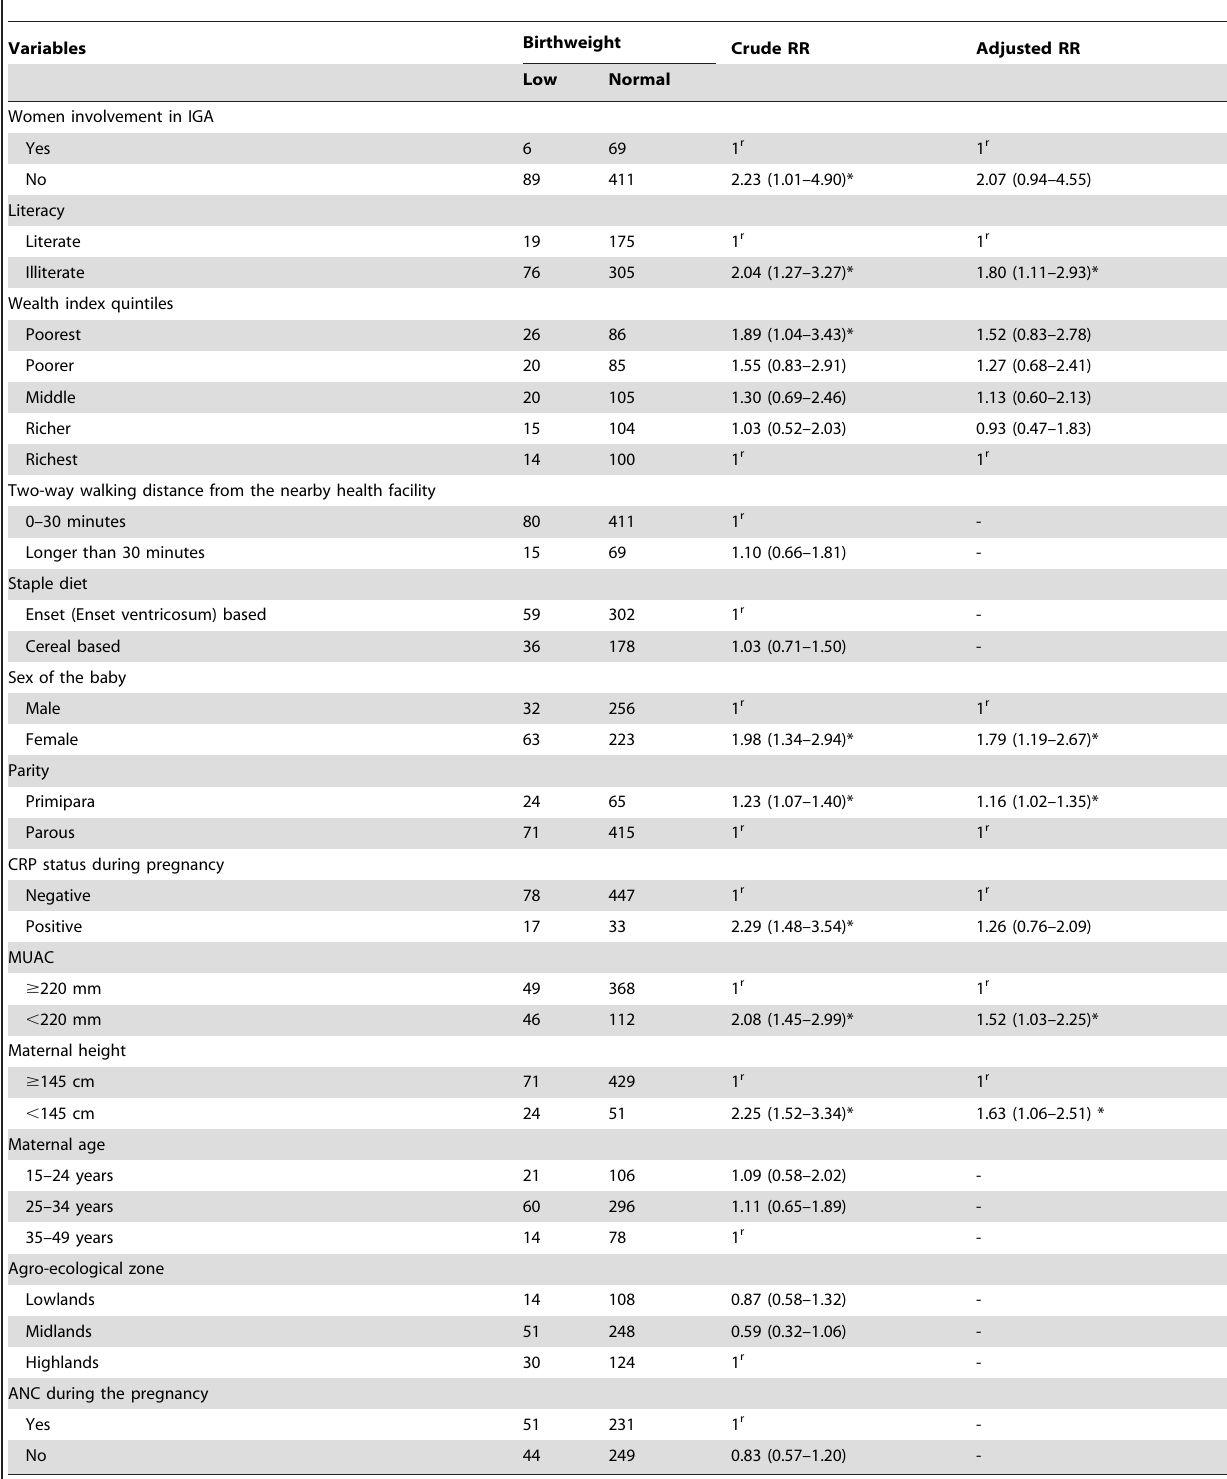
Table 2. Output of the log-binomial regression analysis on general determinants of LBW in rural Sidama, Southern Ethiopia, Jan- Oct